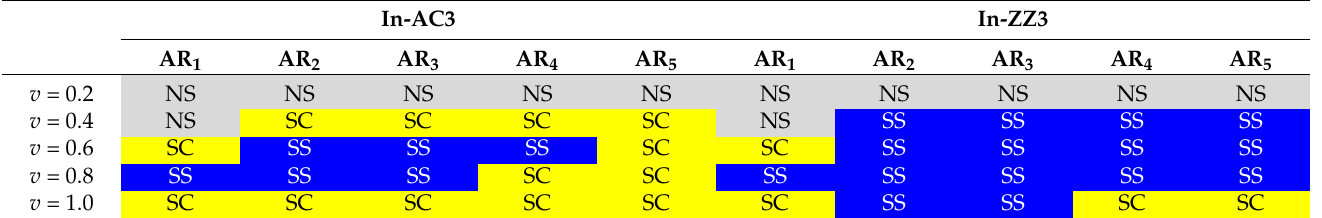
Table 3. Crack propagation styles of the armchair and zigzag cracks in graphene sheets at 1